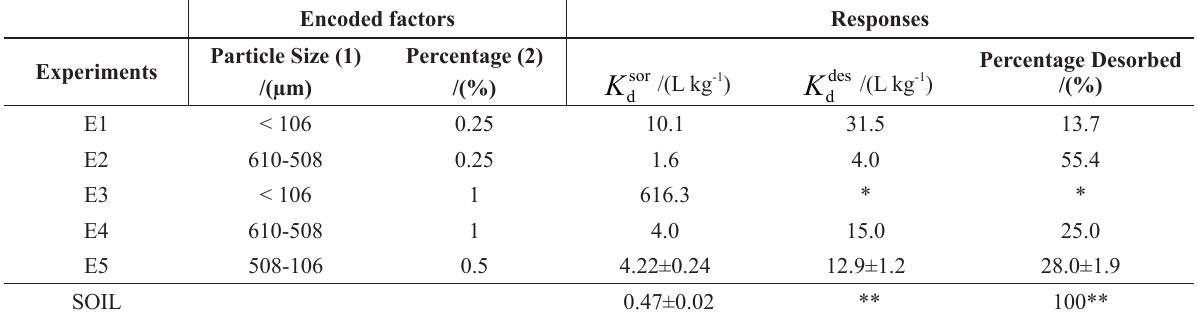
Responses obtained in the experiments of the factorial design and in soil pure in terms of the apparent sorption